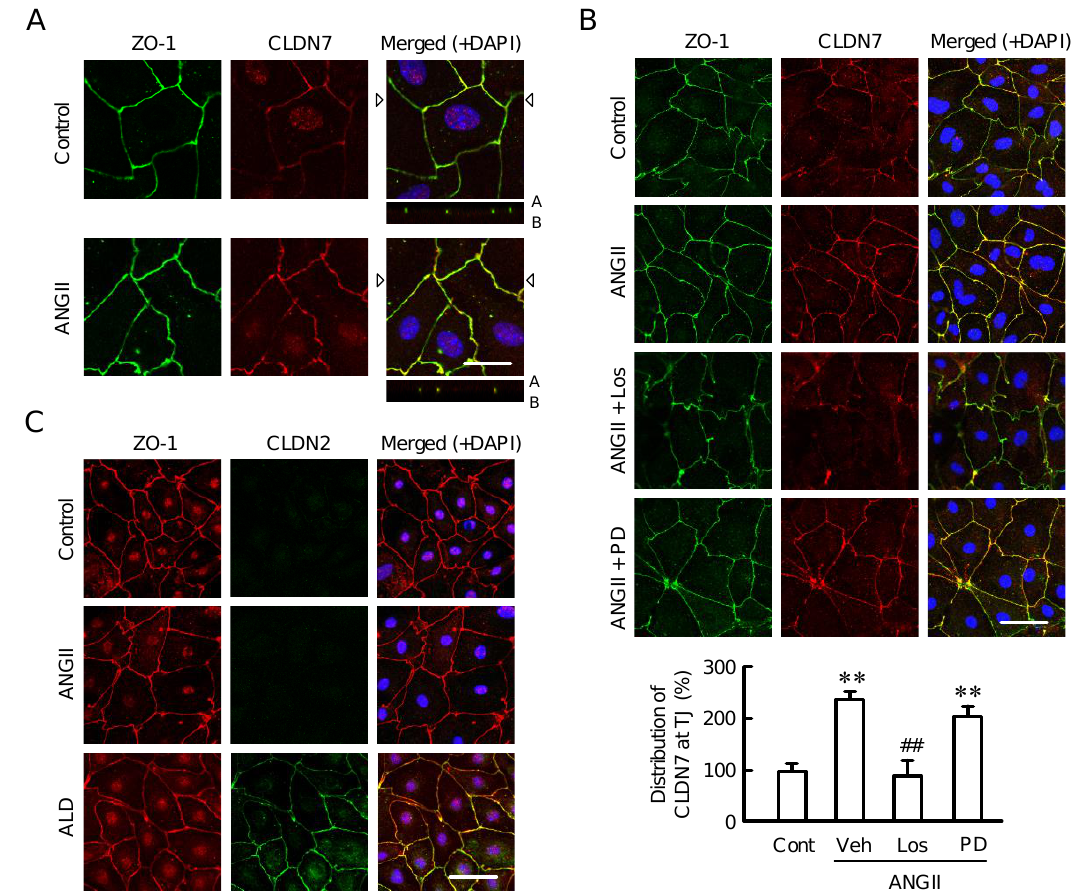
Figure 4. Effects of ANGII on the intracellular localization of CLDN7. ( A ) Cells were treated in the presence and absence of 10 µM ANGII for 24 h. The cells were stained with CLDN7 (red) and ZO-1 (green). Merged images with 4′,6-diamidino-2-phenylindole (DAPI) staining of the nuclei are shown on the right. The lower images represent the xz section. A and B indicate the apical and basal sides, respectively. ( B ) Cells were treated with 10 µM ANGII for 24 h in the presence and absence of 10 µM losartan (Los) or 10 µM PD123319 (PD). The cells were stained with CLDN7 (red) and ZO-1 (green). Merged images with DAPI staining of the nuclei are shown on the right. The distribution levels of CLDN1 in the TJ are shown as percentage of control (Cont). ( C ) Cells were treated with 10 µM ANGII or 50 nM aldosterone (ALD) for 24 h. The cells were stained with CLDN2 (green) and ZO-1 (red). The scale bar represents 20 µm. n = 4–6. ** p < 0.01 significantly different from Cont. ## p < 0.01 significantly different from vehicle (Veh).